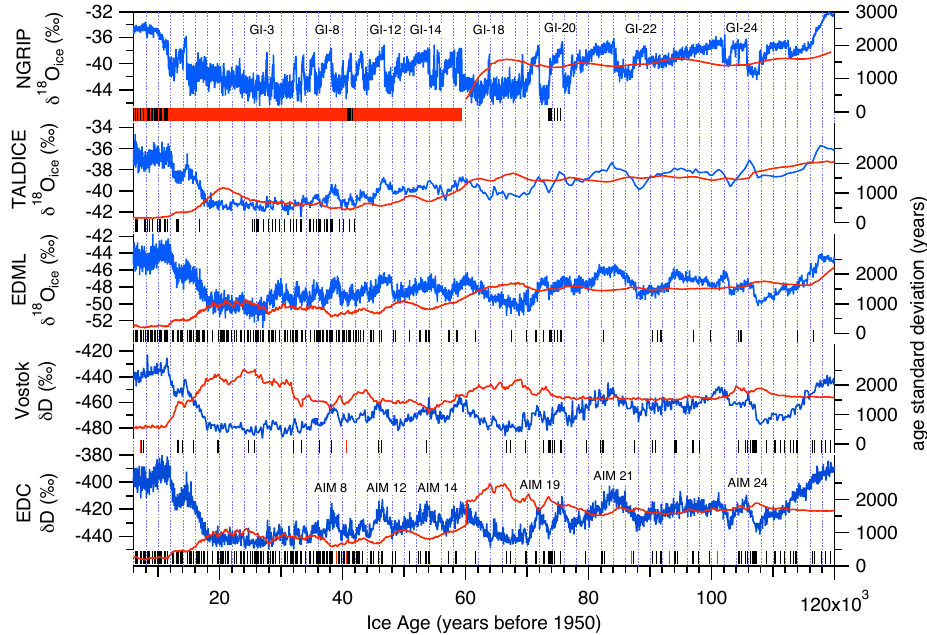
Fig. 1. Water isotopic records from the five ice cores analyzed. From top to bottom: NGRIP (NGRIP members, 2004), TALDICE (Stenni et al., 2011), EDML (EPICA Community Members, 2006), Vostok (Petit et al., 1999), and EDC (Jouzel et al., 2007) on the AICC2012 chronology. Vertical black bars indicate the location of the ice stratigraphic markers and red bars the location of the absolute tie-points in the ice phase. For NGRIP, absolute tie-points are located every meter to closely fit AICC2012 chronology to GICC05 over the last 60ka. The red lines (right axes) show the ice age standard deviation in years for each of the ice core analyzed. GI- refers to Greenland interstadials and the AIM to selected Antarctic Isotopic Maxima